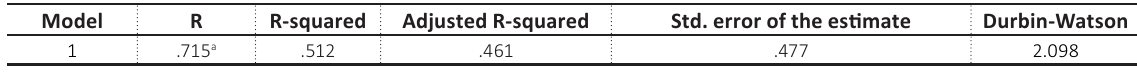
Table 5. Regression model summary – SLC-OC